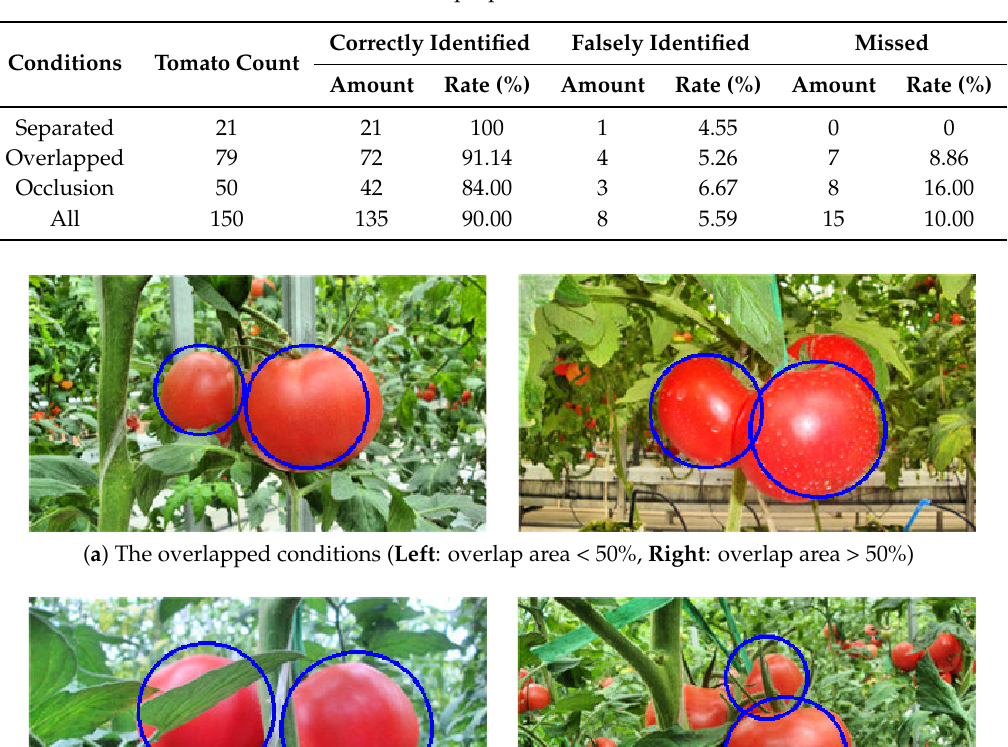
Table 4. The detection results of the proposed method under different conditions.